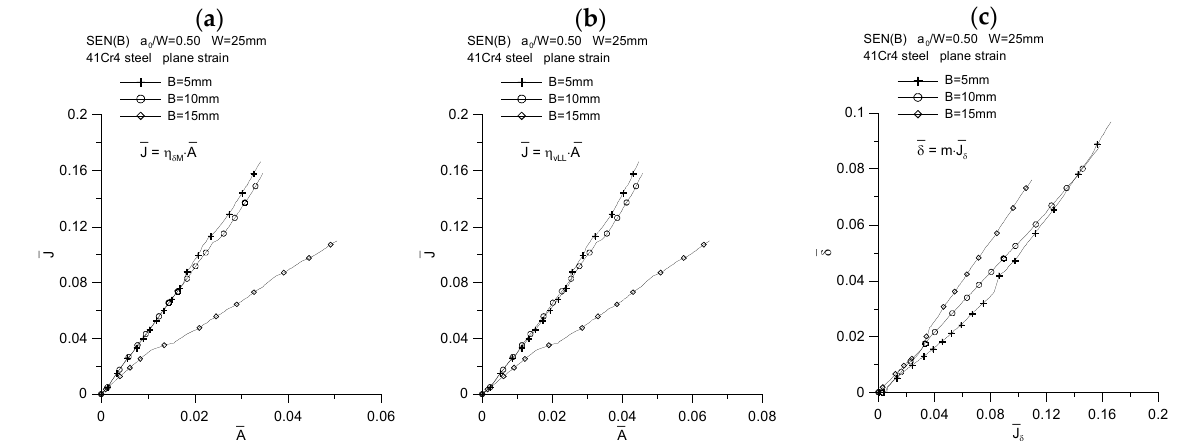
Figure 17. The influence of the specimen thickness on the value of the proportionality coefficient between the J ‐ integral and the energy required to increase the crack length ( a , b ) and on the proportionality coefficient between the crack tip opening displacement and the J ‐ integral ( c ), for the SEN(B) specimen made of 41Cr4 steel.